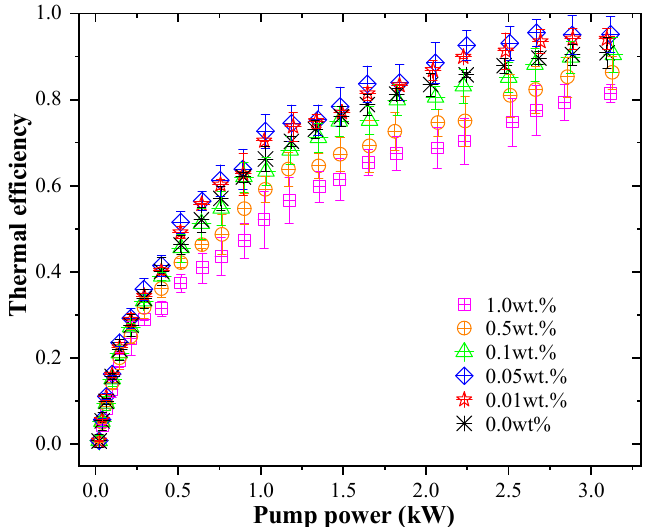
Figure 6. Pump power versus thermal e ffi ciency of heat exchanger.